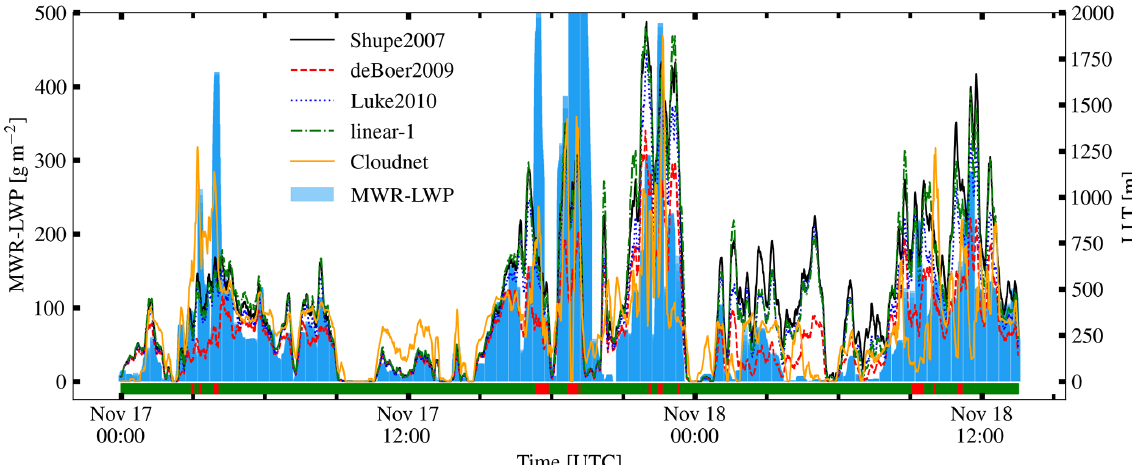
Figure 4. Comparison of MWR-LWP (left y axis, blue bars) and liquid layer thickness (LLT, right axis) of the ANN-predicted liquid layer masks and Cloudnet LLT (orange) for the 17–18 November 2014 case study for all used liquid-detection thresholds. The disdrometer-based Cloudnet rain flag is depicted by green and red markers near the bottom of the plot respectively, indicating profiles with rain (red) and times where it was drizzle-/rain-free or precipitation rates were too low to be observed by the disdrometer.